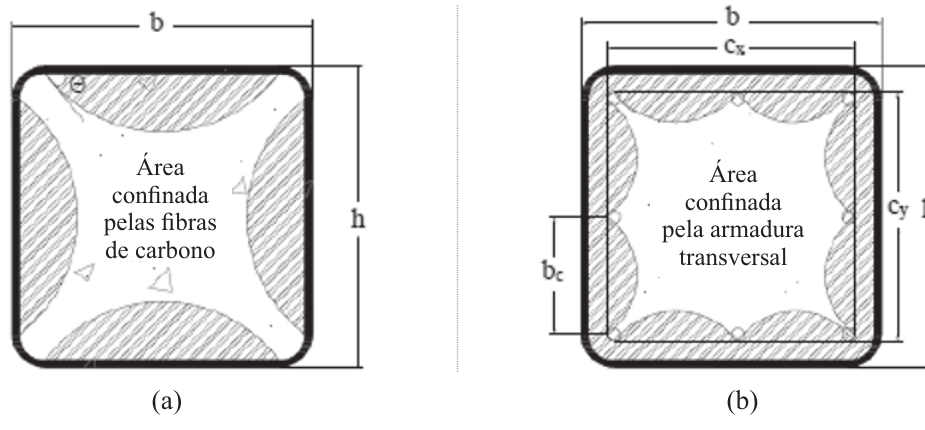
Figura 2 Área do pilar efetivamente confinada. (a) Confinamento pelos PRFC; (b) Confinamento pela armadura